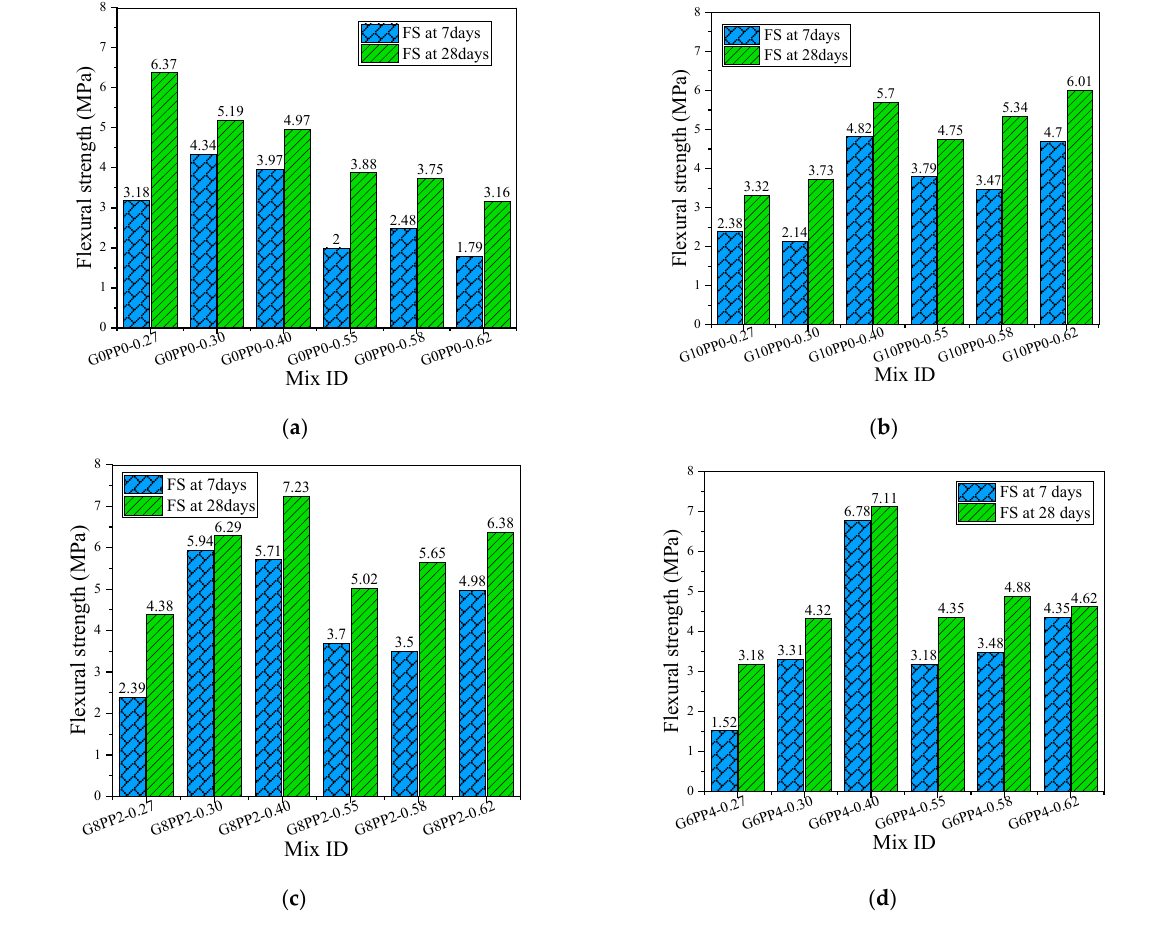
Figure 3. Flexural strength of mortar: ( a ) The flexural strength of mortar in group 1; ( b ) The flexural strength of mortar in group 2; ( c ) The flexural strength of mortar in group 3; ( d ) The flexural strength of mortar in group 4.